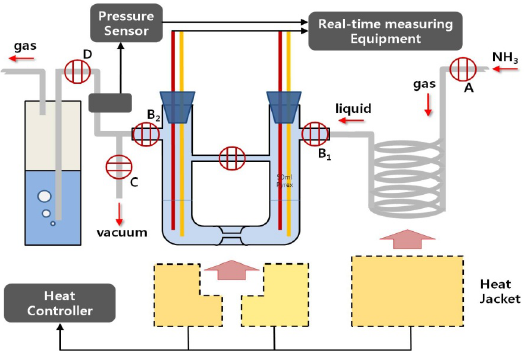
Figure 2. Overall thermoelectric experiment system used in this study for the preparation and decomposition of pure potassium-ammonia (K-NH ) solutions: injection of pure 3 potassium into the cell is carried out in the glove box with an anhydrous and deoxidized inside. After that, both preparation and decomposition of the solutions proceed in the cell’s inside, in which a vacuum is recreated after the cell is connected to this system. A: NH gas 3 input valve; B : Liquid NH input valves; B : NH gas exhausting valves; C: Vacuum 1 3 2 3 control valve; and D: silicon oil exhausting trap.